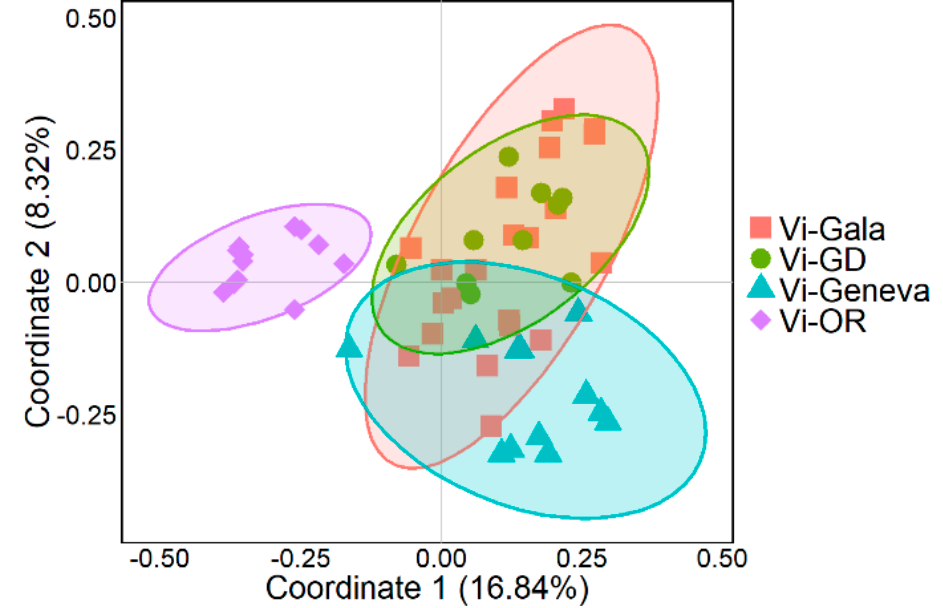
Figure 4. Results of the principal coordinate analysis (PCoA) of the 66 V. inaequalis isolates based on seven SSR markers (the ellipses represent 95% confidence ellipses; colors and point shapes indicate subpopulations defined by different original host cultivars; numbers in parenthesis represent the proportion of variation explained by the coordinate).